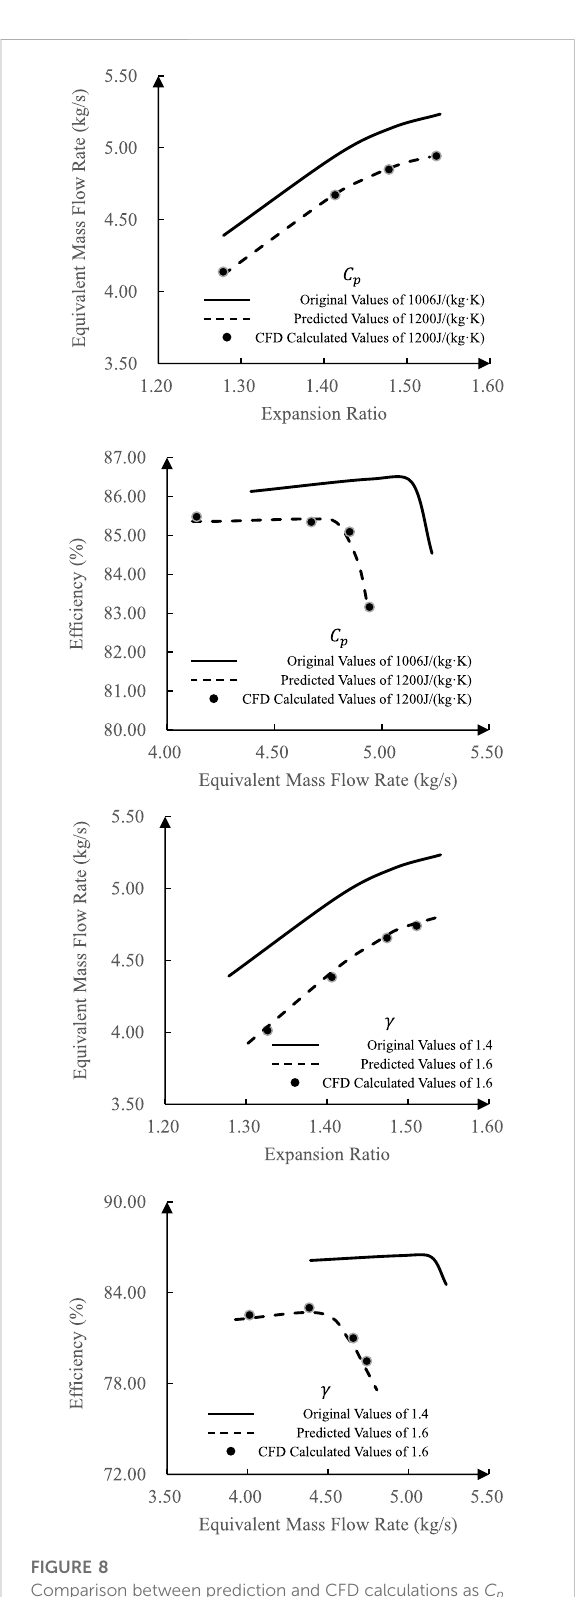
FIGURE 8 Comparison between prediction and CFD calculations as C p and γ evolve in the 2.5-stage